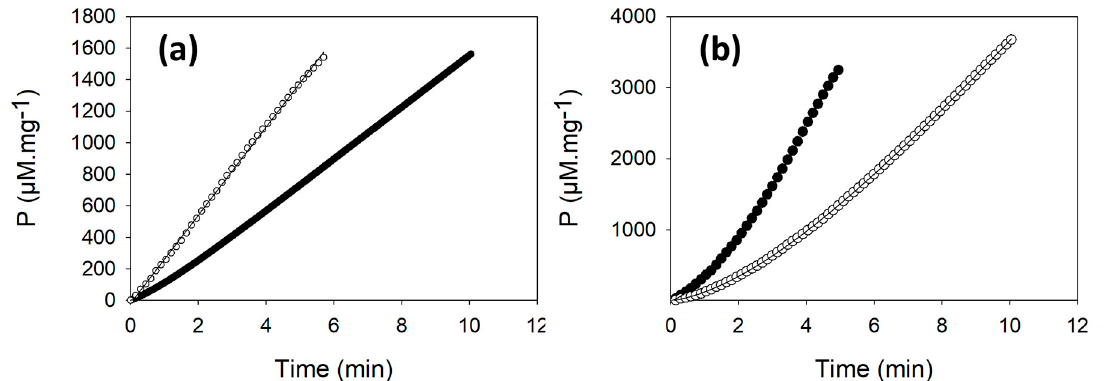
Figure 2. Representative progress curves of appearance of the product of the NADPH dependent GAPDH ( a ) and PRK ( b ) activities. The activity of the two enzymes was measured in the crude extract of WT-Cr (full circles) or of ∆ CP12-Cr (empty circles) cells without pre-treatment with DTT. P corresponds to the product concentration in µmol·L − 1 per mg of total proteins (µM·mg − 1 ) in cell extracts. The quantity of proteins from WT-Cr and ∆ CP12-Cr cell extracts used in the GAPDH activity assays were, respectively, 84 and 64 µg. In the shown PRK activity assays, 43 and 34 µg of proteins from WT-Cr and ∆ CP12-Cr cell extracts were used. The experimental results are fitted to Equation (2) (Materials and Methods), except for the NADPH dependent GAPDH activity progress curve from the ∆ CP12-Cr cell extract that is fitted to a straight line.